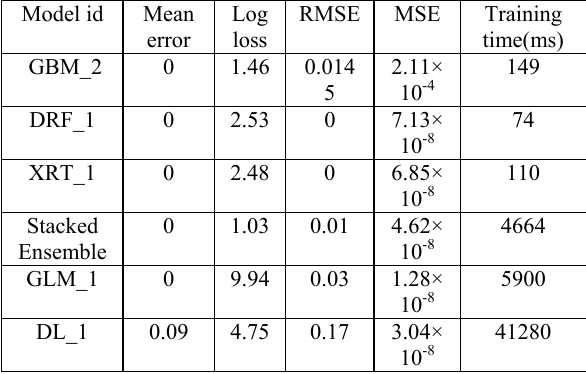
Table 3. Results of metrics on different ML models